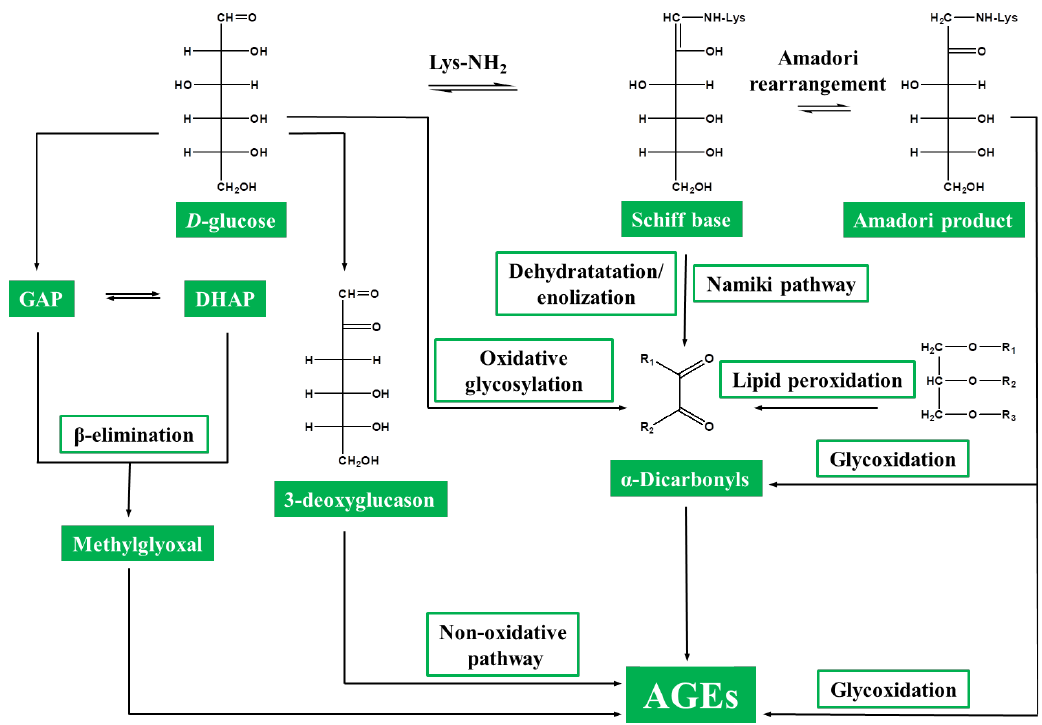
Figure 1. Pathways of AGE formation. AGEs, advanced glycation end products; GAP, glyceraldehyde-3-phosphate; DHAP, dihydroxyacetone phosphate.